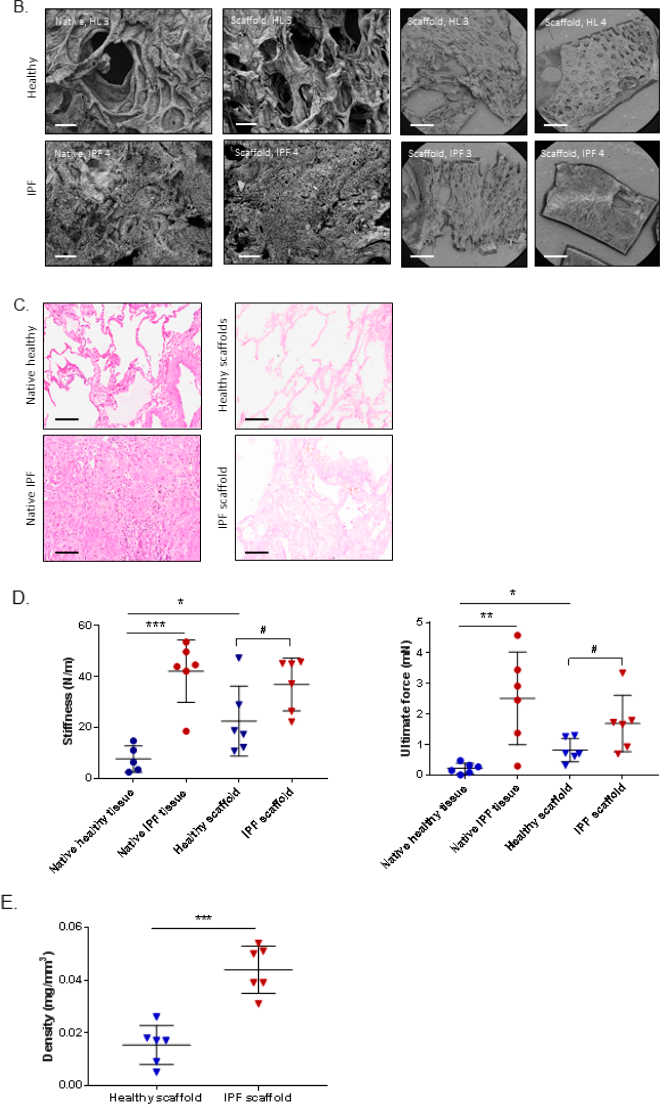
Figure 1. Characterization of native lung tissue and sca ff olds ( A ) Schematic of experimental layout. Dissection and decellularization of 350 µ m human lung tissue slices (1). Mounting of repopulated sca ff olds pre-cultured in SILAC medium (2). Schematics of culture conditions and sample extractions (3). Mass spectrometry (MS) analysis on light (green bars) and heavy (purple bars) protein intensities (m / Z, protein mass / protein charge) illustrating the mass shift of 6 Da (Arg) or 8 Da (Lys) between pre-existing (sca ff old extracellular matrix (ECM)) and newly produced matrisome proteins (4). Intensity / µ g was adjusted for tissue density resulting in intensity / mm 3 (5). ( B ) Representative scanning electron microscopy (SEM) images with the same magnification (scale bar = 100 µ m) of native tissue (left) and decellularized tissue (sca ff old) (middle) and sca ff olds at an overview (right, scale bar = 1 mm) for illustration of sample variability (right). ( C ) Hematoxylin and eosin staining of native lung tissue and corresponding sca ff old after decellularization of the tissue (scale bar = 100 µ m). ( D ) Sti ff ness and ultimate force measurements of biological replicates ( n = 3, with two technical replicates except for native healthy tissue) from native healthy and idiopathic pulmonary fibrosis (IPF) lung tissue and corresponding sca ff olds ( n = 4, with two technical replicates) derived from healthy and IPF tissue. ( E ) Density measurements of healthy and IPF sca ff olds ( n = 2, with three technical replicates). Unpaired t -test for significance between patient groups with p -values * p < 0.05, ** p < 0.01, *** p < 0.001. Sti ff ness # p = 0.068, Ultimate force # p =